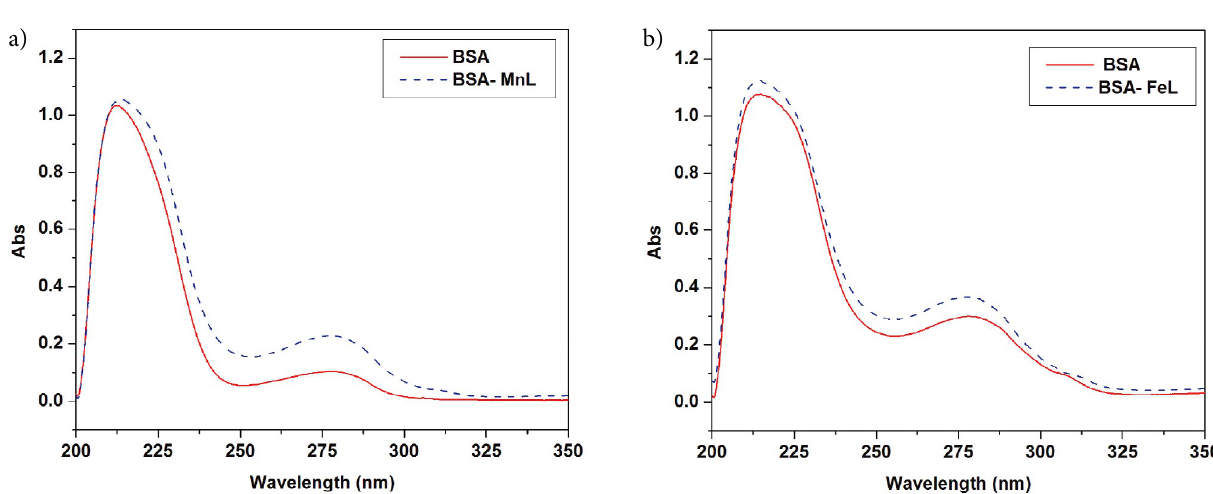
Fig. 6: UV-Vis absorption spectra of BSA and BSA-Metal complex solutions: c (BSA) = c (Metal complex) = 2 × 10 –6 mol L –1 . (a) BSA-MnL solution (b) BSA-FeL solutions